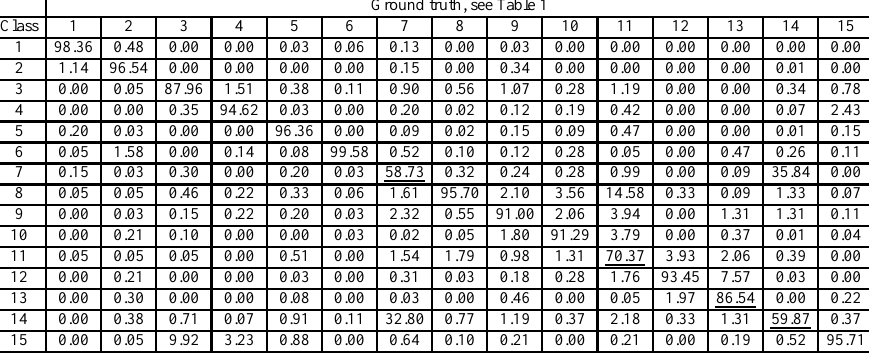
Table 3: Confusion matrix of the FG classification on Salinas benchmark (MNF 20 features, alphabet size: 100). Overall accu- racy=81.3692, Kappa=0.7921 Percentages are given for an easier interpretation. Ground truth, see Table 1